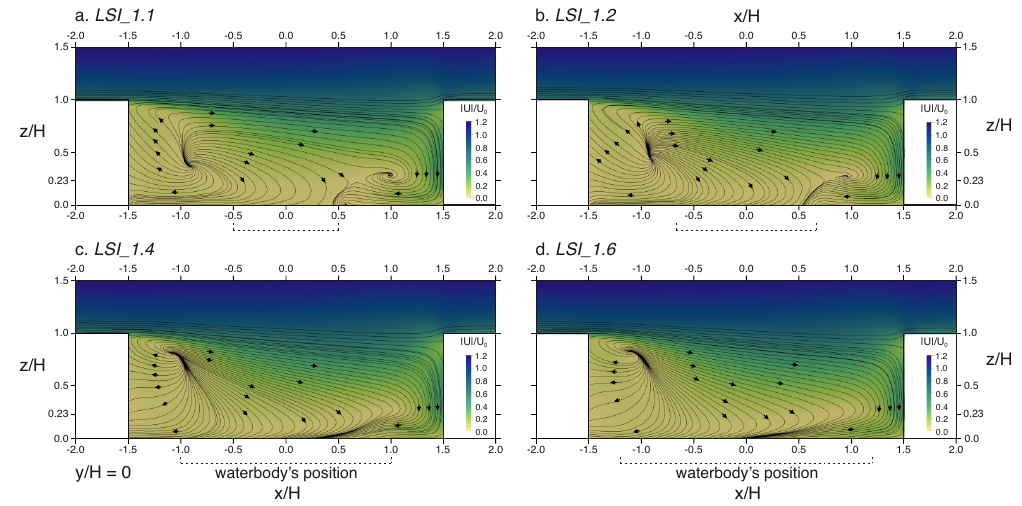
Figure 14. Velocity streamlines for the cases with a cooler water body ( ∆ T = − 2 K) and different shapes over a vertical plane at y / H = 0 in the open square ( − 1.5 ≤ x / H ≤ 1.5). Normalised velocity magnitude is depicted spatially in the background: ( a ) original square water body ( LSI_1.1 ); ( b ) LSI_1.2 ; ( c ) LSI_1.4 ; ( d ) LSI_1.6